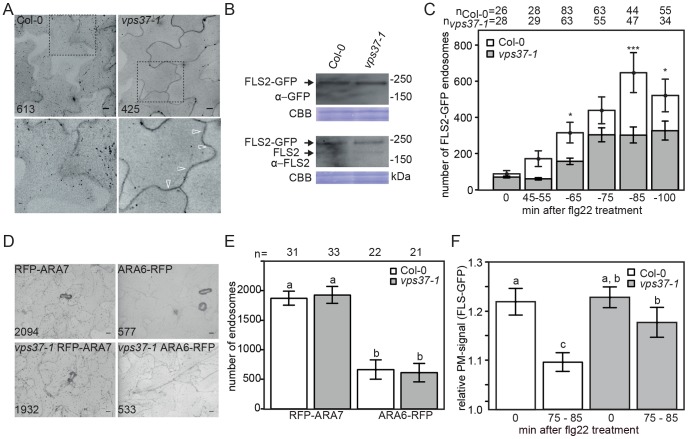
Flg22-induced endocytosis of FLS2 is compromised in vps37-1 mutants but not steady-state ARA6/RabF1 and ARA7/RabF2b endosomal numbers.(A) High-throughput confocal micrographs show Arabidopsis cotyledon cells of the indicated FLS2-GFP transgenic lines treated with 10 µM flg22 for 80 min. Detail pictures show FLS2-GFP endosomes (indicated with arrows); bar = 10 µm; numbers indicate total endosomes. (B) Immunoblot detection of endogenous FLS2 and transgenic FLS2-GFP protein accumulation in homozygous Col-0 and vps37-1 plants. Coomassie brilliant blue (CBB) is used as loading control. (C) Quantification of FLS2-GFP endosomal numbers upon treatment with 10 µM flg22 at the indicated times and genotypes. Error bars represent mean values +/− SE; n>26<83 images. Asterisks indicate statistical significance of p<0.05 (*) and p<0.001 (***). (D) High-throughput confocal micrographs show Arabidopsis cotyledon cells of the indicated ARA6/RabF1-RFP and RFP-ARA7/RabF2b transgenic lines; bar = 10 µm; numbers indicate total endosomes. (E) Quantification of ARA6/RabF1-RFP and RFP-ARA7/RabF2b endosomal numbers. Error bars represent mean values +/− SE; n images. Letters indicate statistical significance of p<0.05. (F) Quantification of the FLS2-GFP fluorescence signal at the plasma membrane upon treatment with 10 µM flg22 at the indicated times and genotypes. Error bars represent mean values +/− SE; n = 50. Letters indicate statistical significance (p<0.05, ANOVA and Tukey's honestly test). These experiments have been repeated three times.